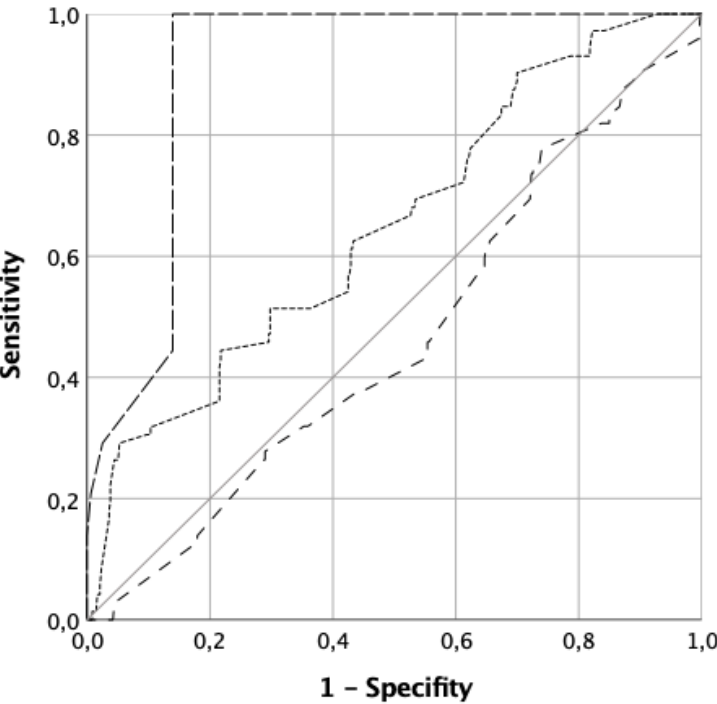
Figure 2. ROC curve analysis: sensitivity and specificity of tumor number, total tumor size, and maximum tumor size in predicting bilaterality.